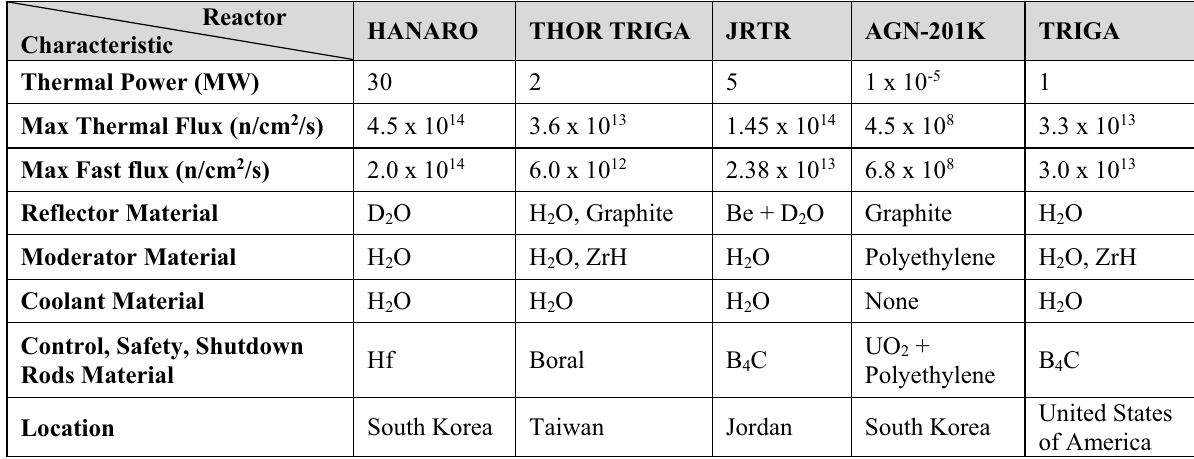
Table I. Research Reactors: Characteristics [5]